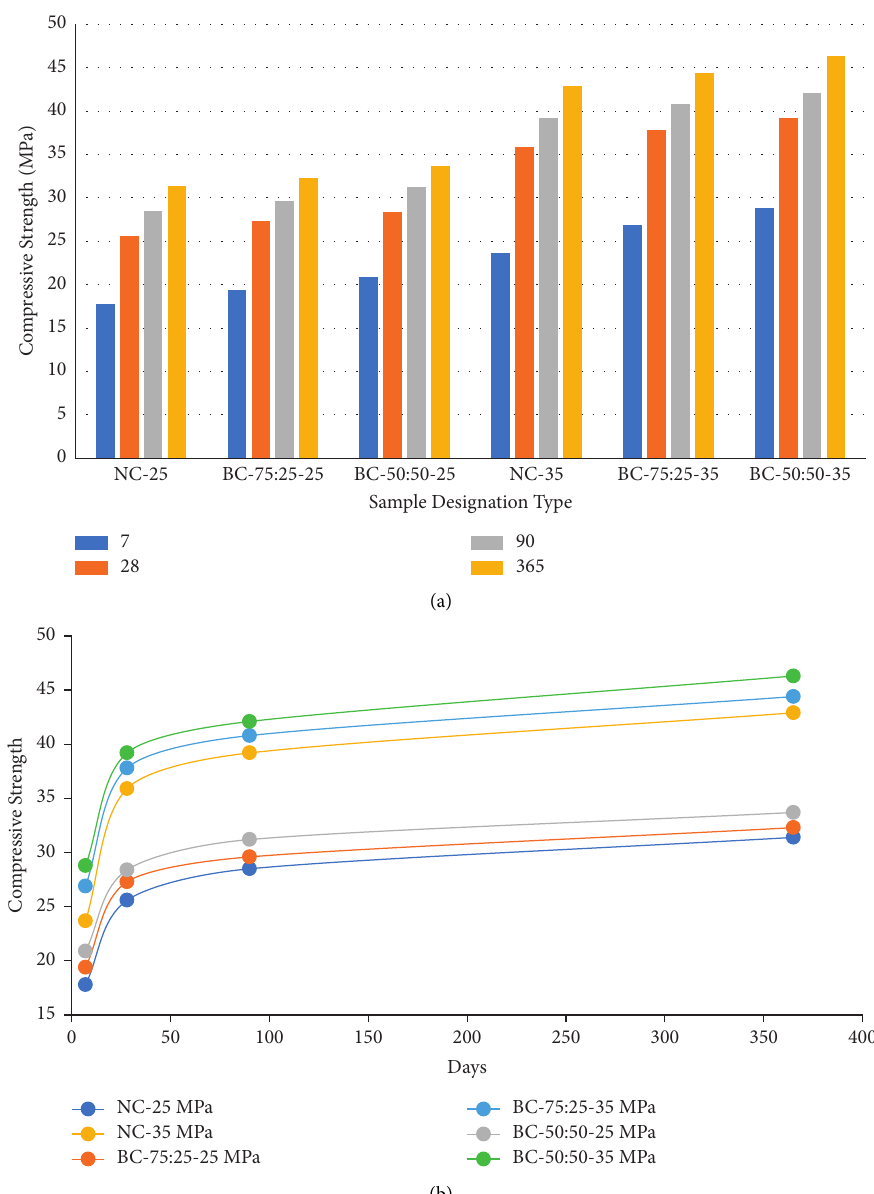
Figure 5: Variation of compressive strength for various concrete under increasing curing